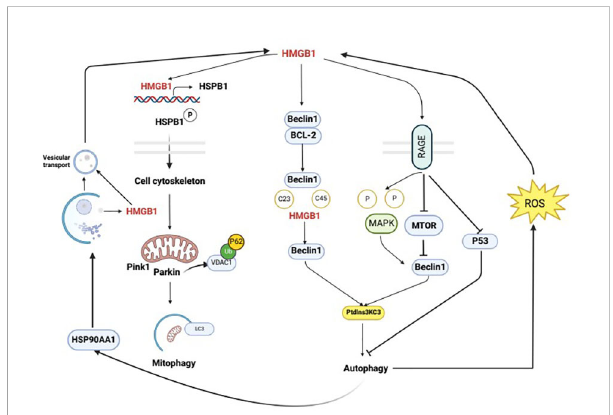
FIGURE 3 Mutual regulation mechanism of autophagy and